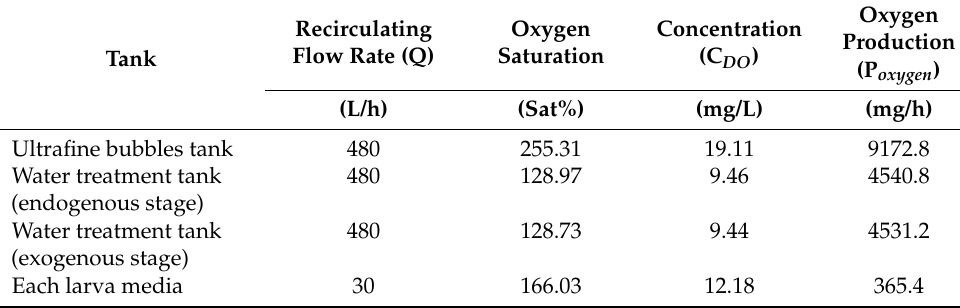
Table 3. The oxygen supply and production in